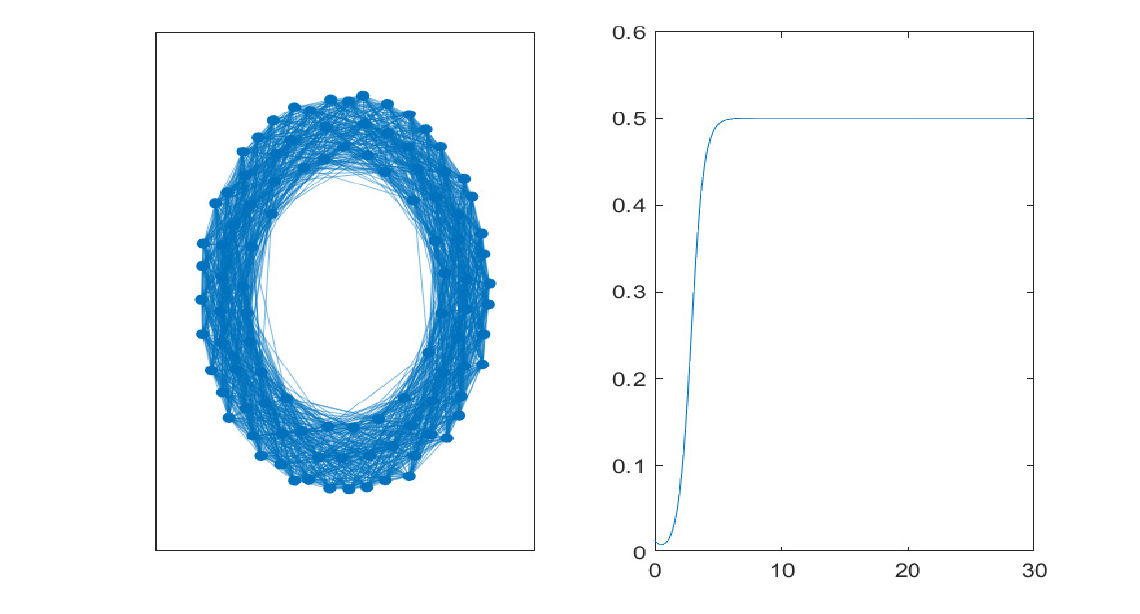
Figure 6. Small-world (Watts-Strogatz) network with 100 nodes and a rewiring probability of β = 0 (ring) ( left ). Time evolution of the mean value of non-performing loans on the graph ( right